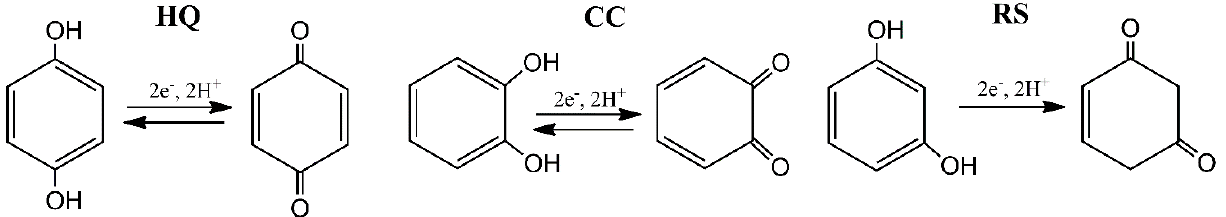
Figure 7. The electrooxidation mechanism of HQ, CC, and RS.